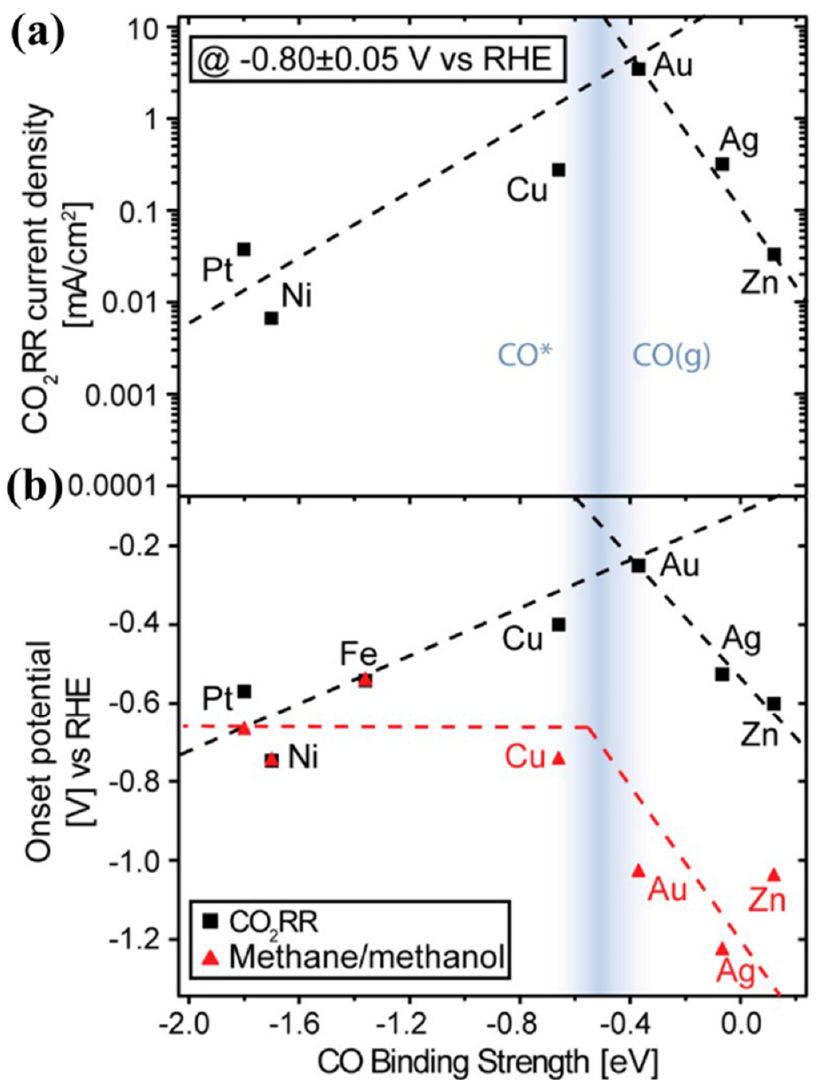
Figure 3. ( a ) Volcano plots of CO 2 RR with partial current density vs. CO binding strength. ( b ) Three distinct onset potentials plotted vs. CO binding strength: the HER, the overall CO 2 RR and methane or methanol. Reproduced with permission from Ref. [79]. Copyright 2014, American Chemical Society.